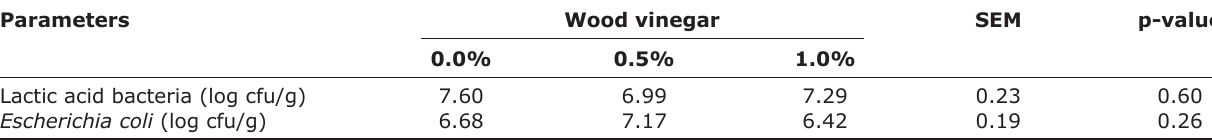
Table-3: Effect of drinking water supplemented with wood vinegar on gut microbial of broiler